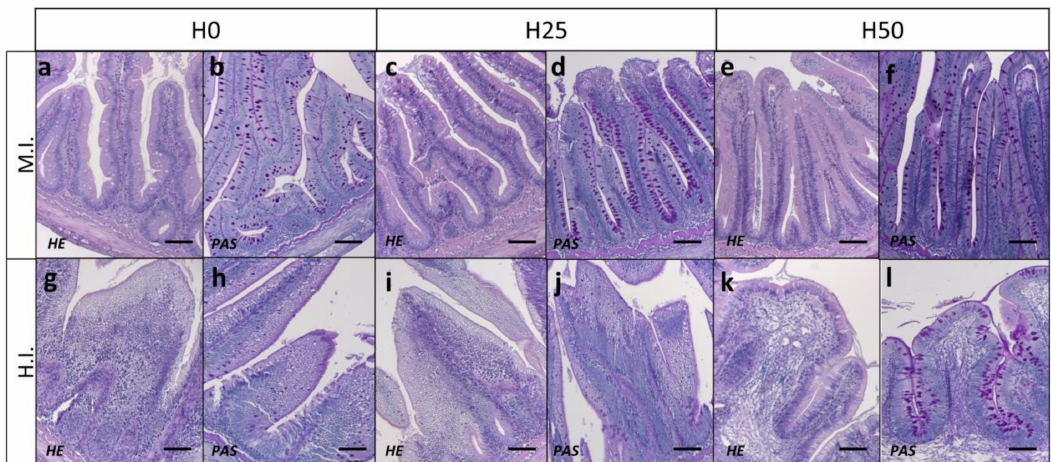
Figure 4. Histology of medium (M.I.) and hind (H.I.) intestine from the di ff erent feeding groups (H0, H25 and H50). Section were stained with haematoxylin and eosin (HE) and periodic acid of Shi ff ( PAS ).